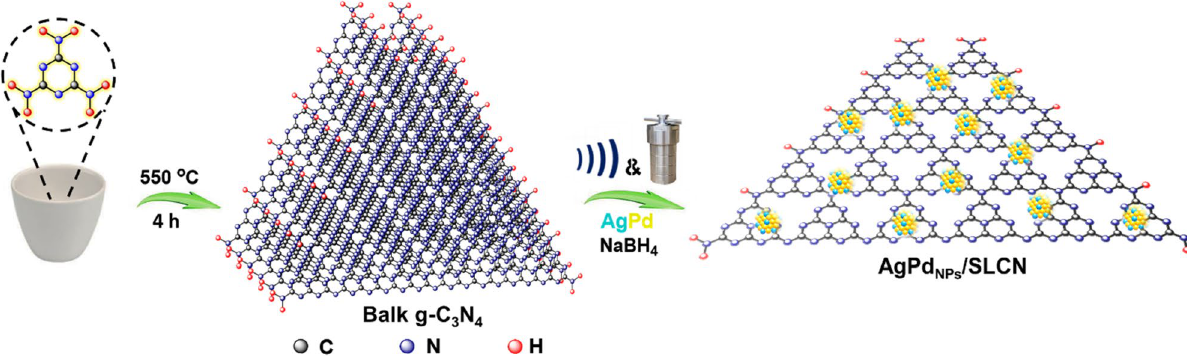
Figure 1. Schematic illustration for the synthesis of AgPd NPs /SLCN.